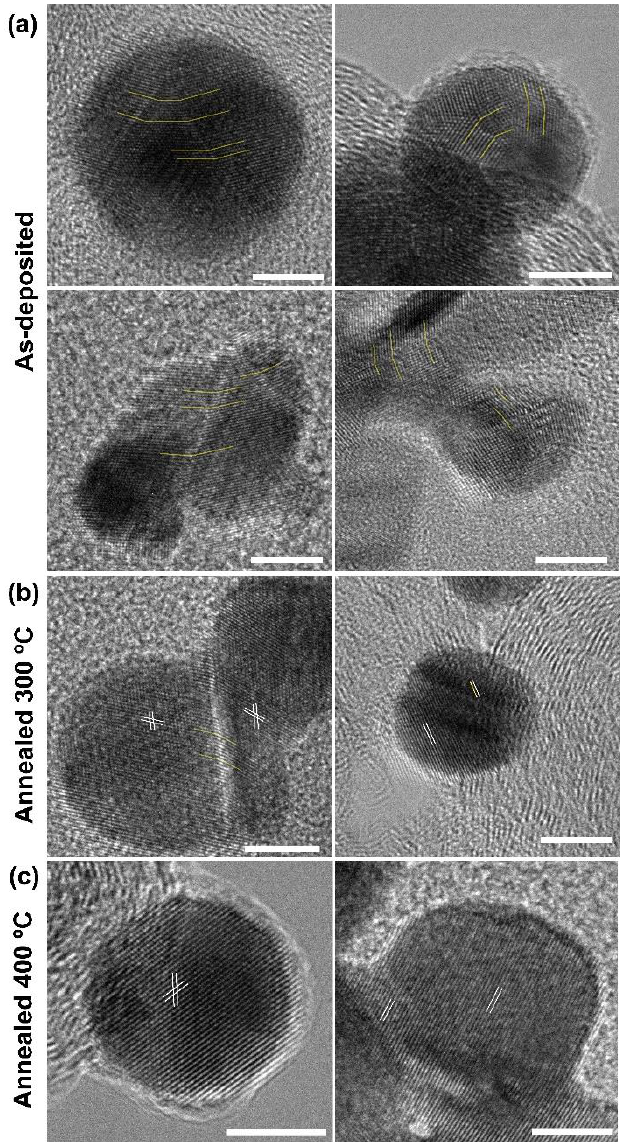
Figure 5. High–revolution TEM images of as–prepared ( a ) and annealed Au/CFP electrodes at 300 °C ( b ) and 400 °C ( c ). The light yellow lines indicate GBs in the Au NPs. The white lines indicate the lattice fringe spacing for Au NPs. The scale bar represents 5 nm.